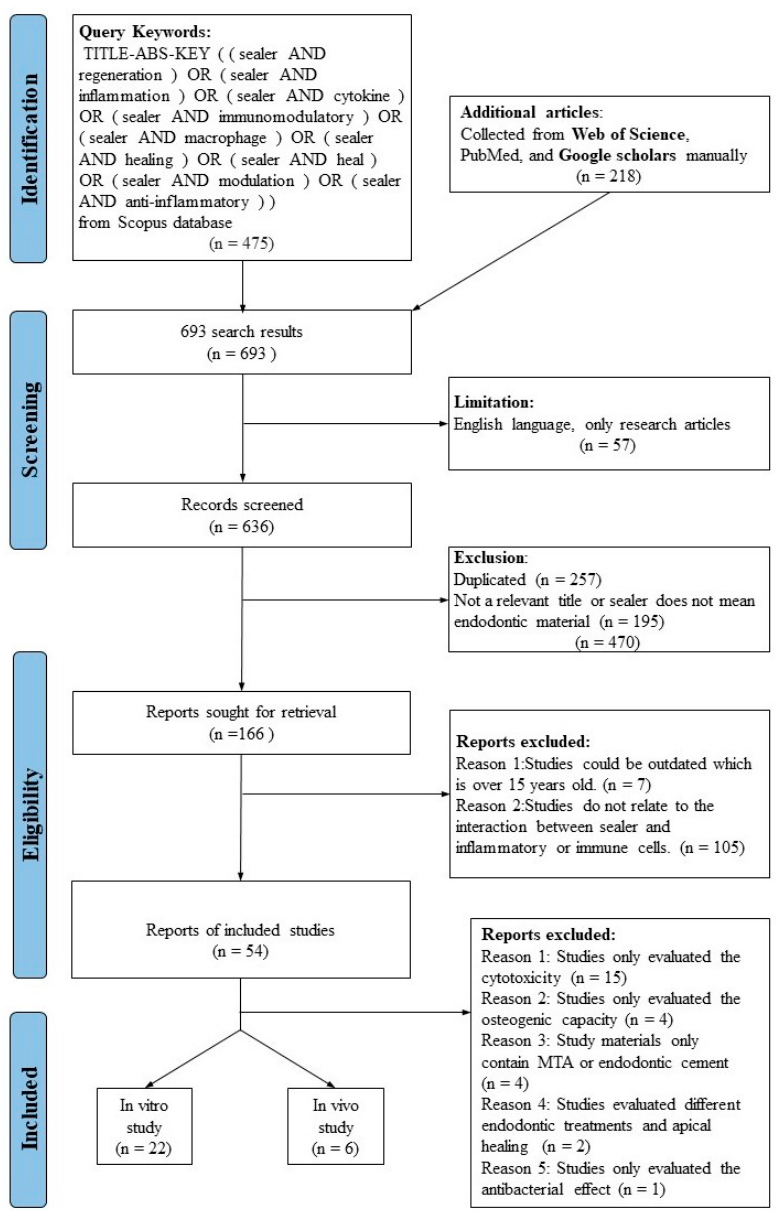
Figure 1. Study design based on PRISMA.